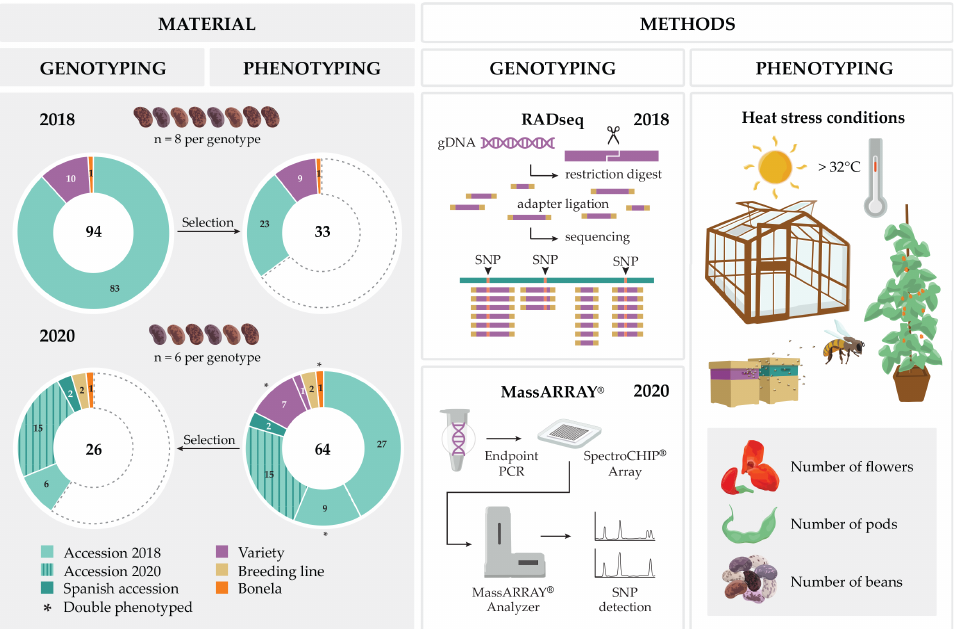
Figure 1. Trial design. The left block describes the material used for geno- and phenotyping in the two experimental years: In 2018, out of 94 genotypes that were genotyped, 33 were selected for the glasshouse trial, whereas in 2020, out of 64 genotypes grown in the glasshouse trial, 26 were genotyped. The right block highlights the methods used for genotyping, RADseq in 2018 and the MassARRAY ® system in 2020, and the phenotyping under heat stress